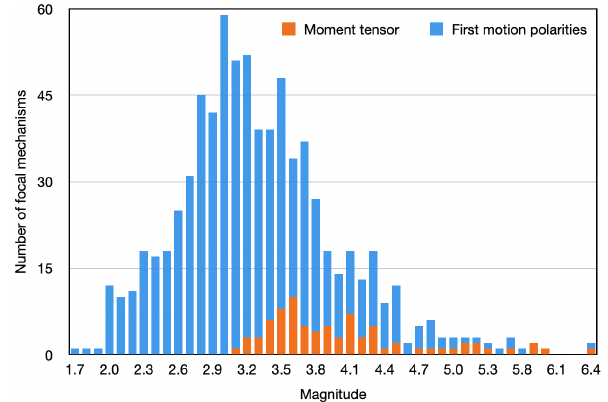
Figure 4. Magnitude distribution of the fault plane solutions con- tained in the catalogue.